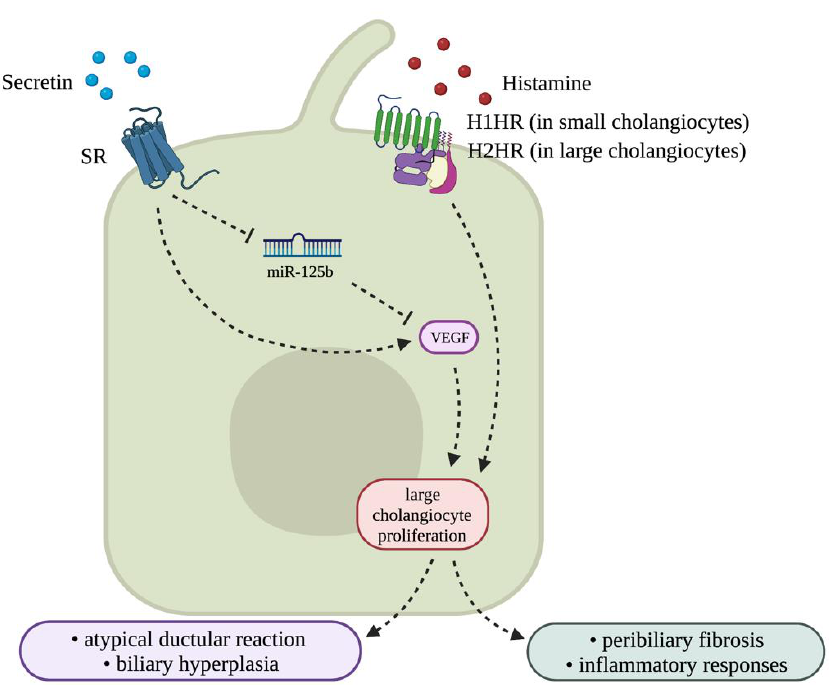
Figure 7. Key neuroendocrine signaling that may play a role in NAFLD. The neurohormones involved in cholestasis are mainly secretin and histamine. Through signaling via secretin receptor (SR) and histamine receptors (H1HR and H2HR), respectively, cholangiocytes can assume a neuroendocrine phenotype during cholestasis that further leads to atypical ductular reaction, biliary hyperplasia, and inflammation. In NAFLD, it has been shown indirectly that elevation of secretin and histamine is a key phenotype, thus suggestive of the role of these neurohormones in the progression of NAFLD. Image made with BioRender (https://biorender.com/).